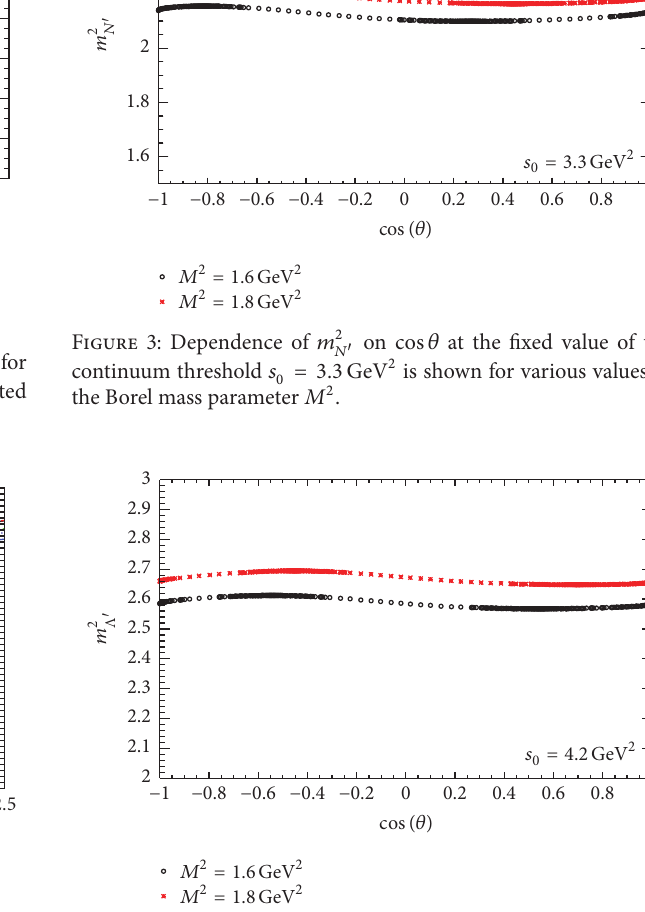
Figure 4: Dependence of 𝑚 2 Λ 󸀠 on cos 𝜃 at the fixed value of the continuum threshold 𝑠 0 = 4.2 GeV 2 is shown for various values of the Borel mass parameter 𝑀 2